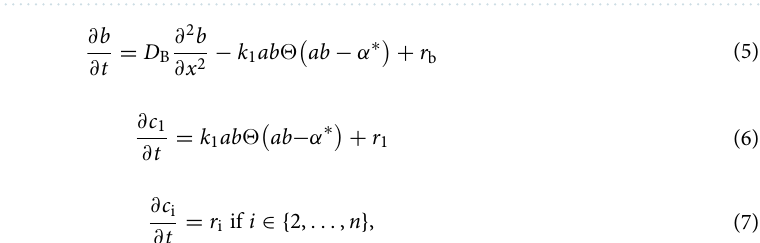
Figure 2. Concentration dependence of the particle size in the middle of the precipitate zone in the reaction– diffusion synthesis represented in SEM images ( a – f ). The ratio of the boundary concentrations was fixed to [Zn 2+ ] 0 :[2-MeIm] 0 = 1:10, and the synthesis time was 24 h. The average particle size (cid:31) d (cid:30) and the polydispersity index (PDI) are given below the SEM